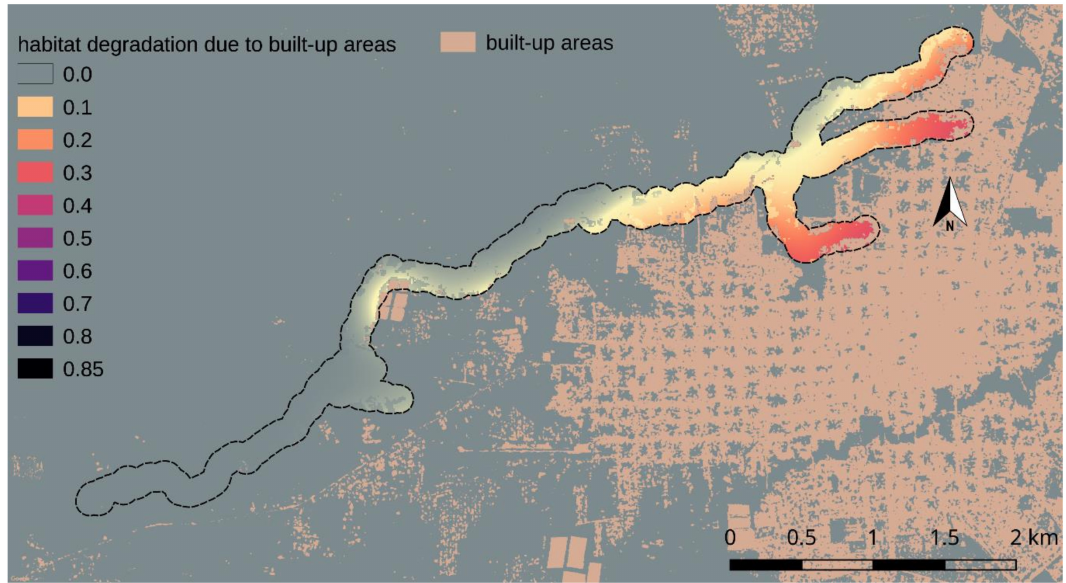
Figure 3. Spatial variation of the threat impact of built-up areas on habitat quality in the study area. The grey shade is used as a background to provide a better illustration.